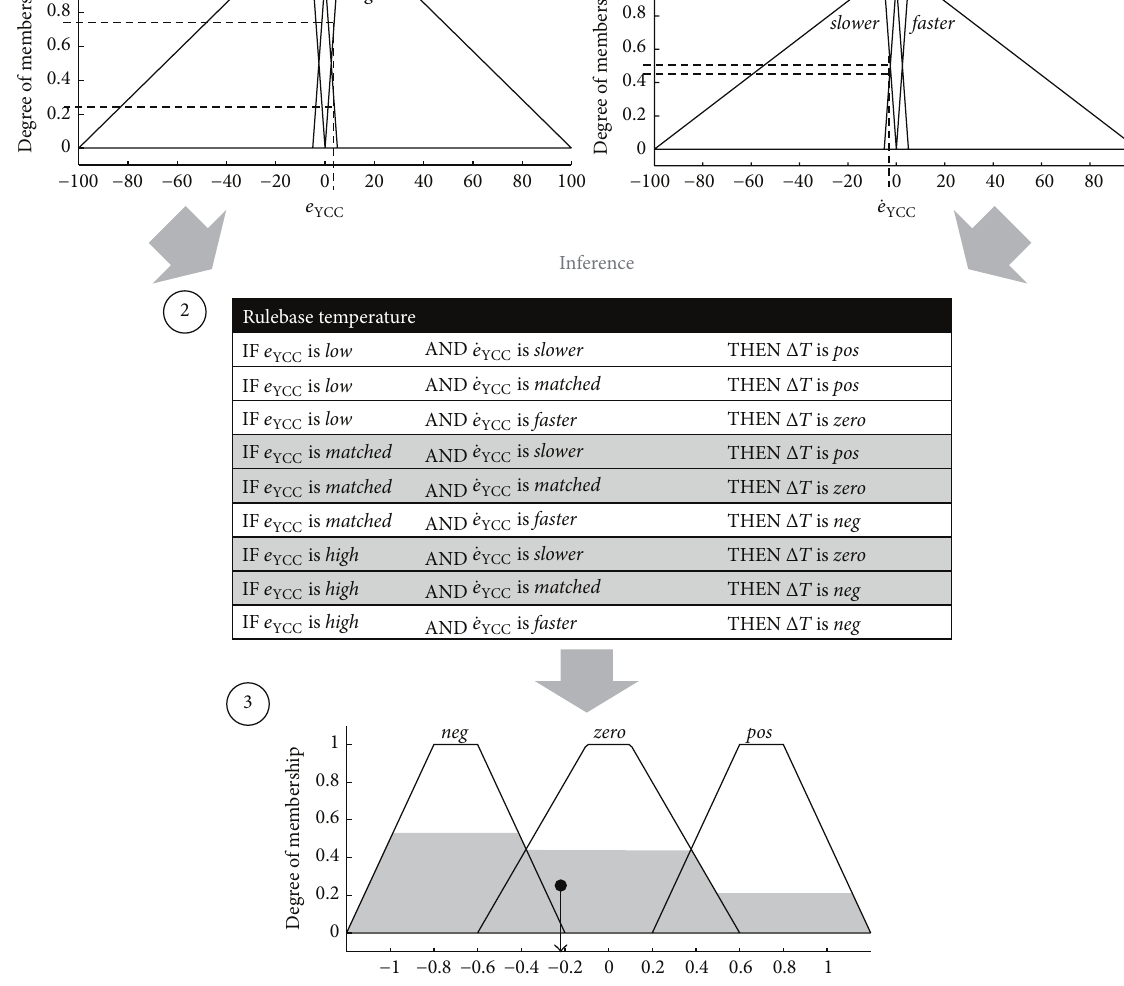
(𝑢 ) is a membership function associated with fuzzy Here, 𝜇 𝐴 𝑗 𝑖 𝑖 𝑗 = {(𝑢 , 𝜇 (𝑢 )) | 𝑢 set 𝐴 𝑖 𝑖 𝑖 𝐴 𝑗 𝑖